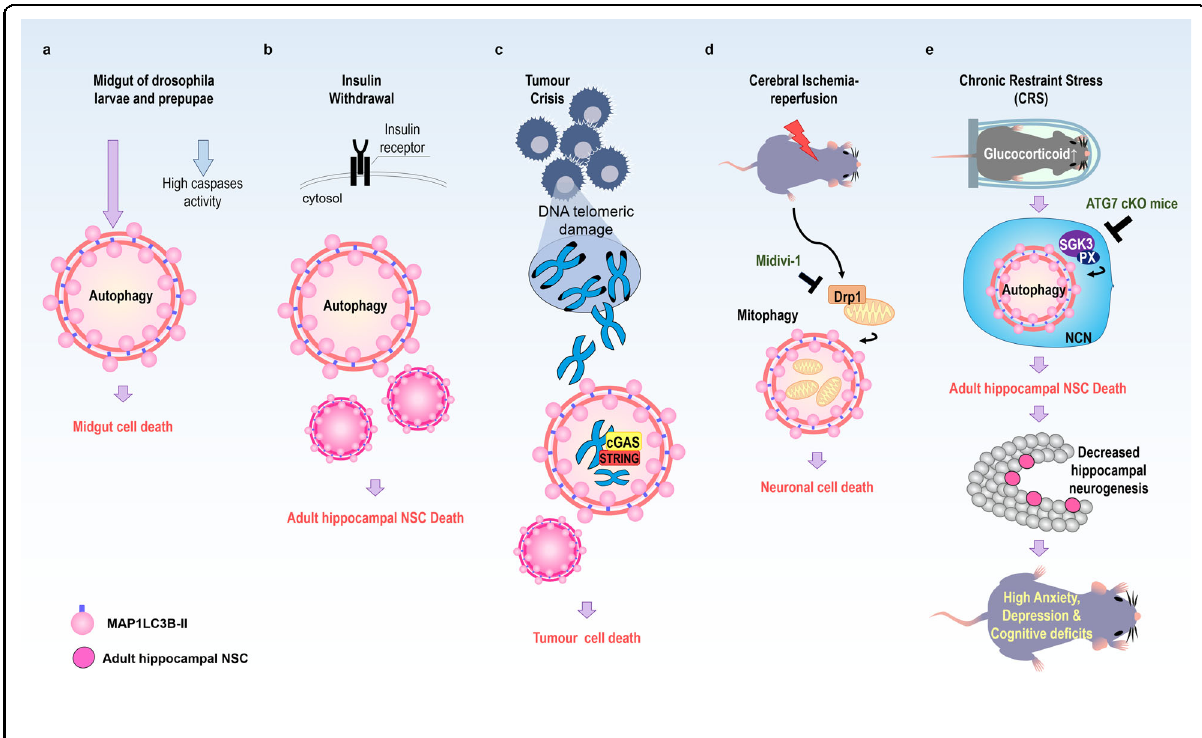
Fig. 1 Representative cases of autophagic cell death (ACD). a The midgut of Drosophila larvae and pupae shows high caspase activity and autophagy fl ux, but midgut cell death depends only on autophagy. b Adult hippocampal neural stem cells (NSCs) undergo ACD following insulin withdrawal without the involvement of apoptosis or necroptosis. c During replicative crisis, DNA with telomeric damage is released into the cytosol and is recognized by cGAS and STRING, which induces ACD. d Cerebral ischemia – reperfusion induces mitophagy in a DRP1-dependent manner with subsequent neuronal cell death. e Chronic restraint stress (CRS) or corticosterone treatment induces ACD in adult hippocampal NSCs via SGK3 in vivo and in vitro. CRS decreases adult hippocampal neurogenesis, which is accompanied by anxiety, depression, and cognitive de fi